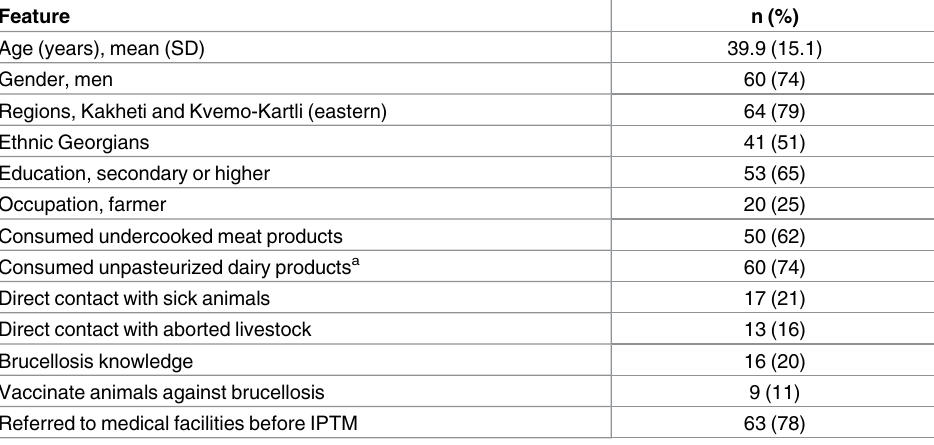
Table 1. Epidemiological characteristics of the study